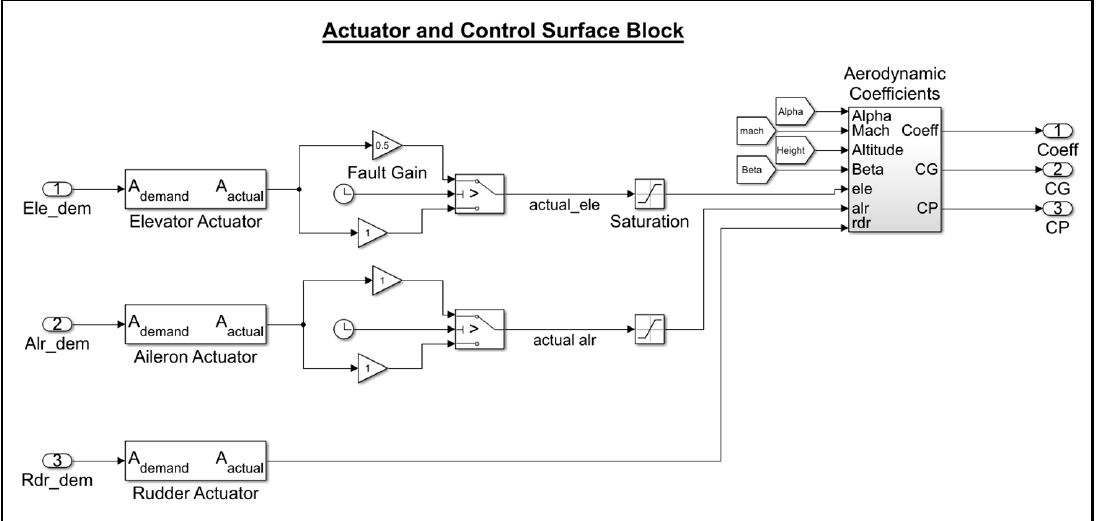
Figure 3. SWIFT VTOL model actuator and control surface block from